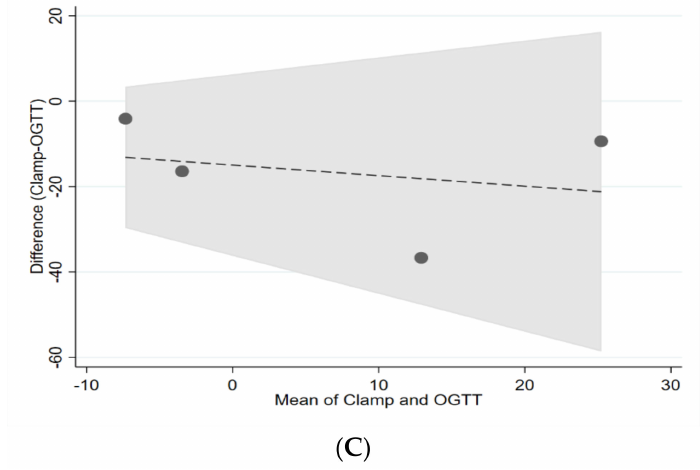
Figure 3. Bland–Altman plots of ( A ) clamp vs. fasting insulin, ( B ) clamp vs. HOMA-IR, ( C ) clamp vs. OGTT. The central dashed line represents the mean difference between measures represented as log values. The area in grey represents the 95% confidence intervals. HOMA-IR = homeostatic model assessment for insulin resistance, OGTT = oral glucose tolerance test.